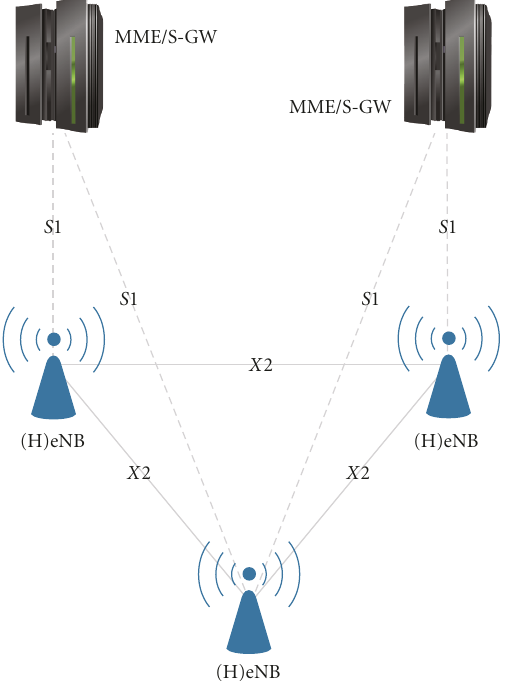
Figure 3: Overall LTE architecture showing S1 and X2 interfaces.